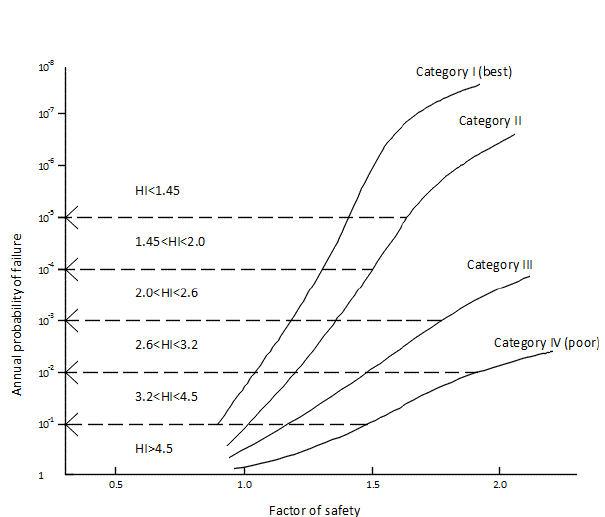
Figure 4. Classification of the engineered slopes and their rela- tion to the annual probability of failure (modified from Silva et al.,